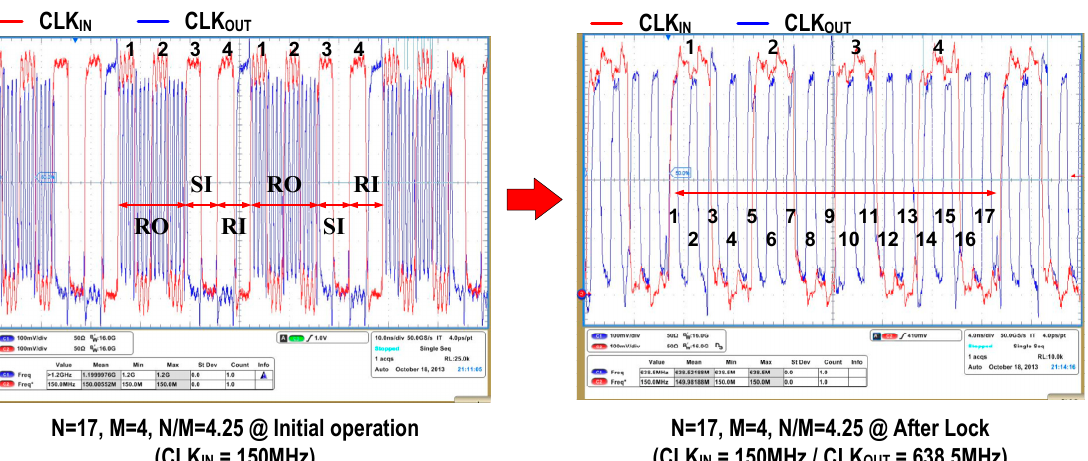
Figure 9. Measured locking process of the proposed N/M ‐ ratio digital MDLL @ N/M = 17/4 = 4.25 and f _CLK IN = 150 MHz. Before lock (Initial Operation, left) and after lock (right).